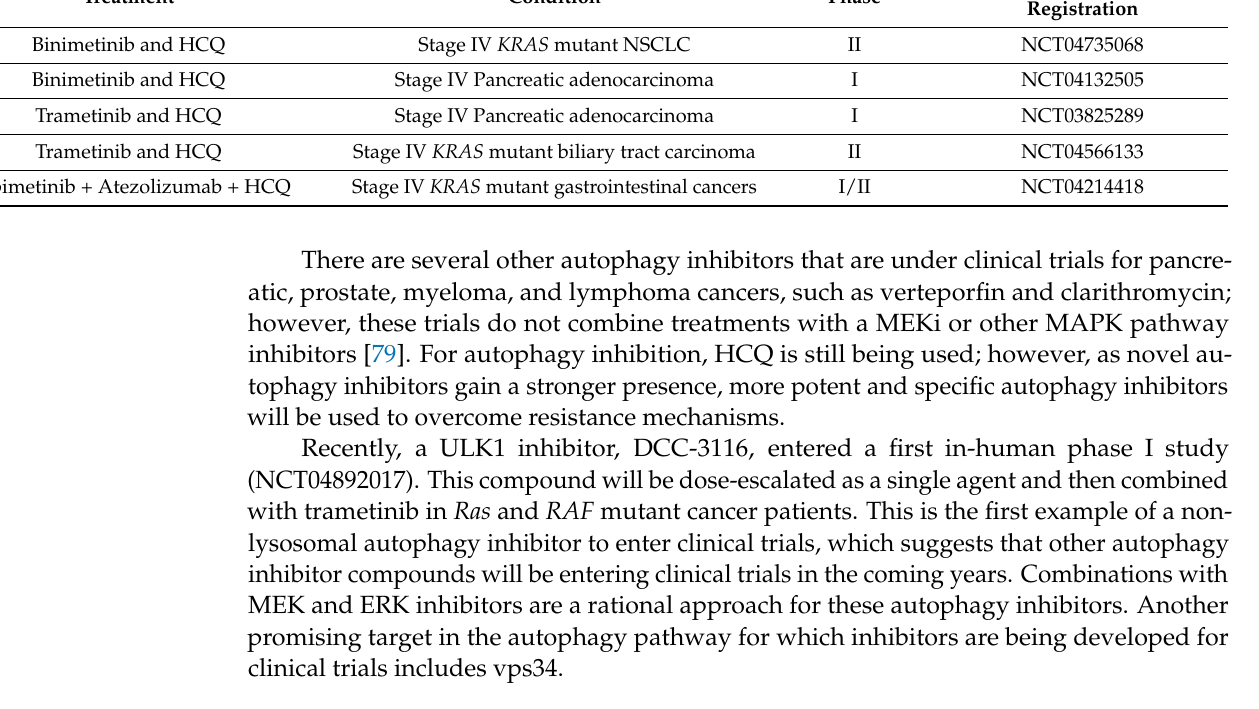
ClinicalTrials.gov